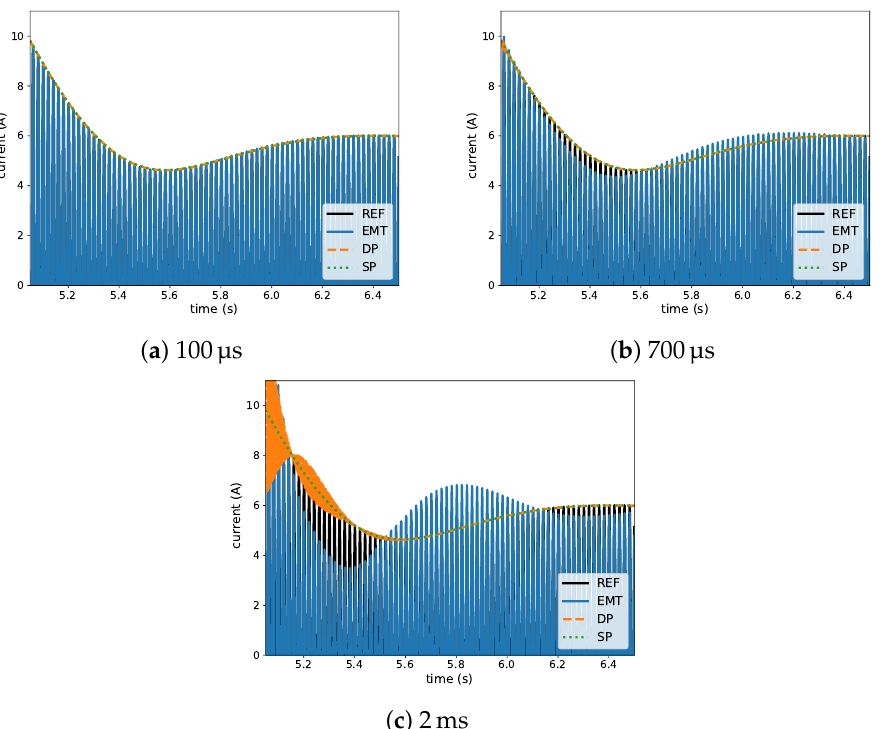
Figure 5. VSI current transient with a closed control loop considering characteristic simulation step sizes of ( a ) 100µs, ( b ) 700µs and ( c )